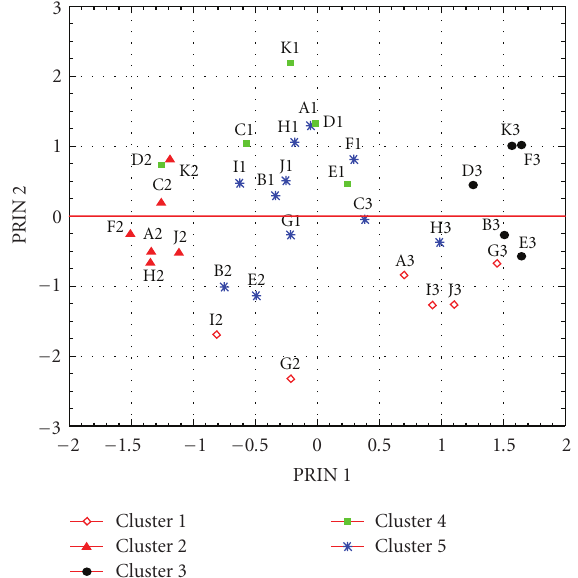
Figure 4: Graphic representation of hybrid behaviour according to first two principal components and identification of clusters for early sowing date (S3). Behaviour is represented by a letter (hybrid code) and a number (location-year